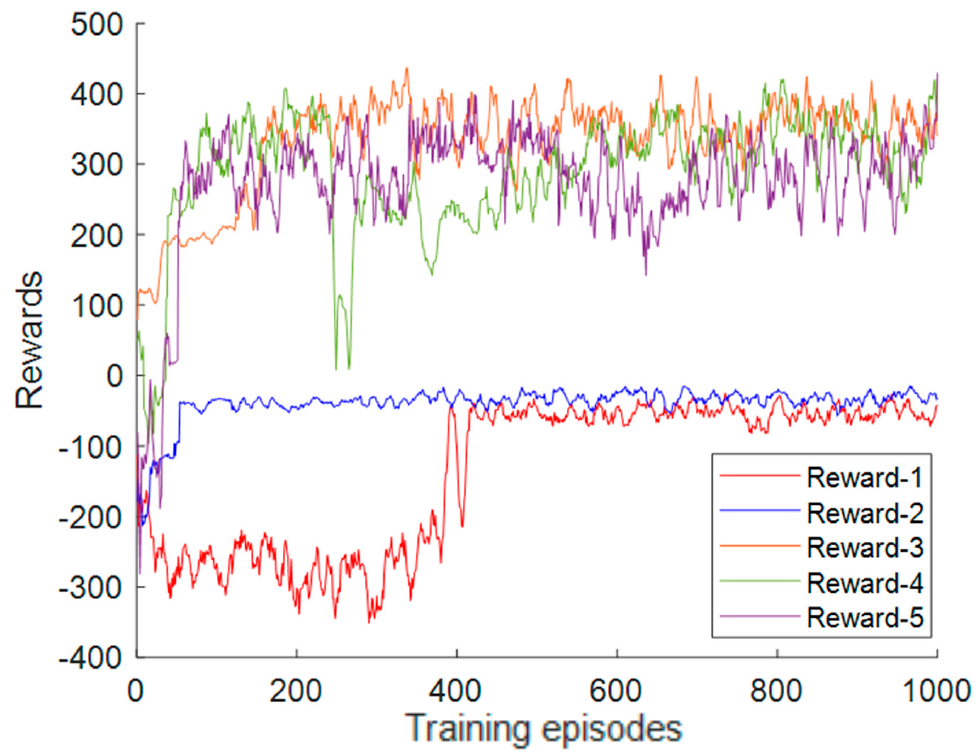
Figure 9. Reward functions for different scenarios.